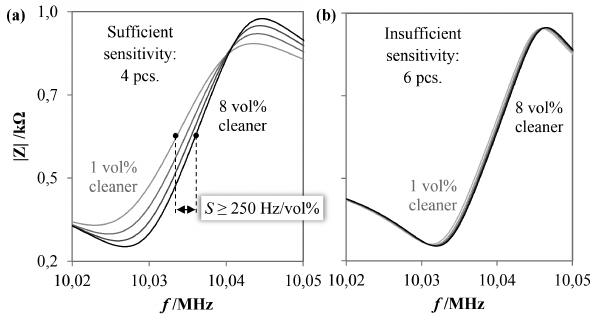
Figure 1. Variance of sensor sensitivity in the sample batch of 10 PVA/PAA-coated TSRs: (a) four sensors have a sufficient sen- sitivity, and (b) six sensors have an insufficient